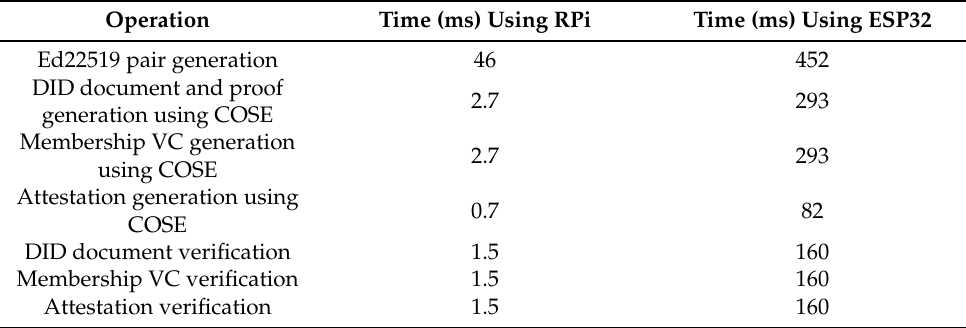
Table 1. Cryptographic operations and their